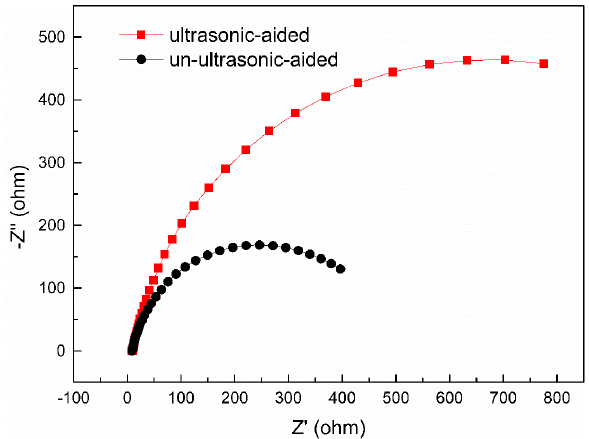
Figure 4. Nyquist EIS spectra of 35CrMoV in artificial seawater solution.